Question: Provide a publication-style caption for this figure.
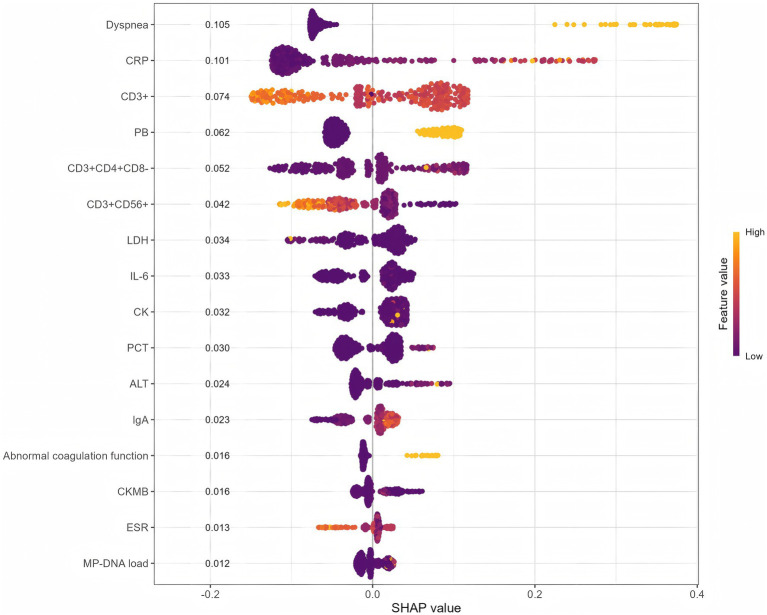
Answer: SHAP summary dot plot illustrating feature effects and non-linear associations. This plot visualizes the directional impact of each feature on the individual prediction of severe pneumonia risk. The vertical axis lists the features in descending order of global importance. Each dot represents a single patient. The horizontal axis indicates the corresponding SHAP value; positive SHAP values (points to the right of the vertical zero line) drive the prediction towards severe illness, while negative values push it towards non-severe illness. The color gradient reflects the actual value of the feature for that specific patient (yellow indicates high values, purple indicates low values).